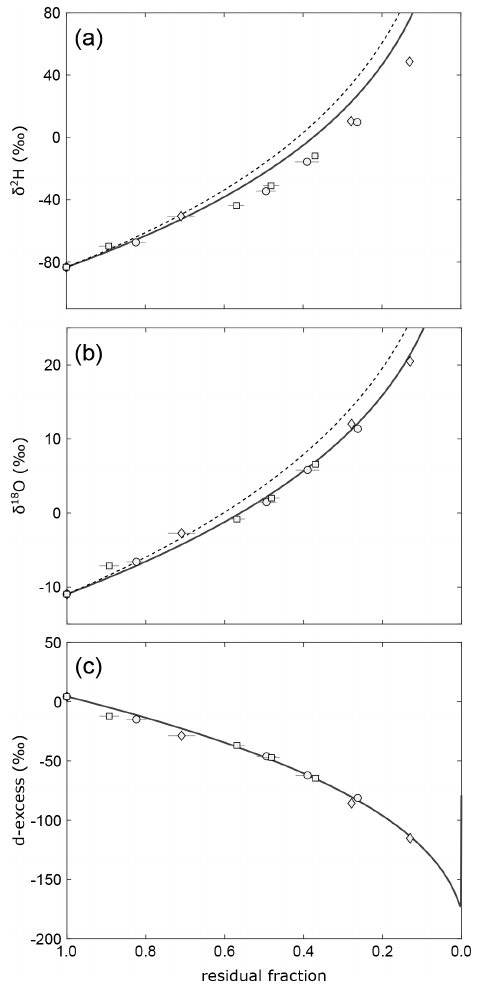
Figure 9. Isotopic evolution of remaining water in evaporation ex- periments, similar to Fig. 8. Here, the red lines show evaporation trajectories obtained by fitting the virtual outlet model ( n = 0 . 59, outlet = 20%). The dashed lines represent evaporation trajectories for the simple evaporation model obtained using the same turbu- lence coefficient as for the virtual outlet